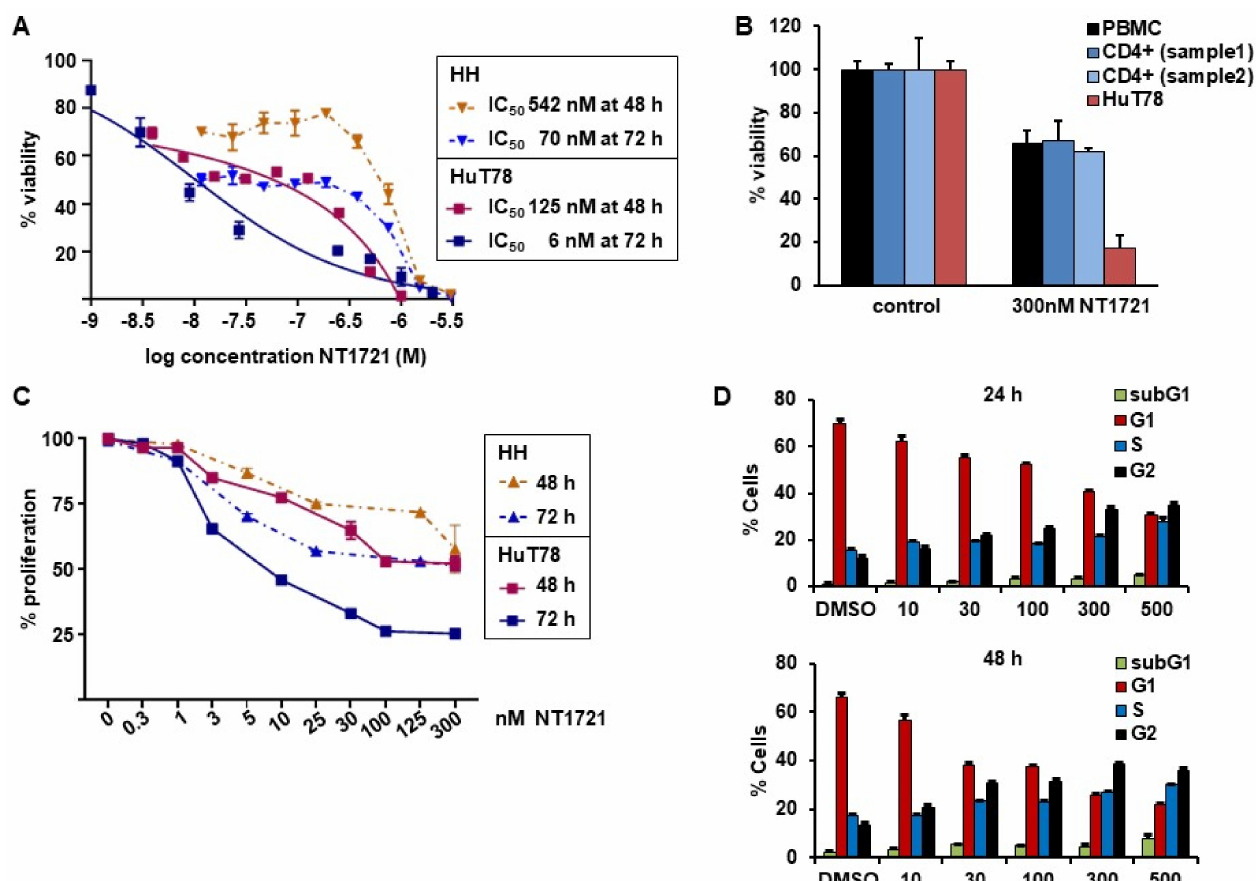
Figure 1. NT1721 decreased CTCL cell viability, proliferation and led to G2 cell cycle arrest. ( A ) Cell viability. HuT78 and HH cells were treated with increasing concentrations of NT1721. Cell viability and IC 50 values were determined after 48 and 72 h. ( B ) Effect of NT1721 on normal cells. HuT78 cells, normal PBMCs and normal CD4 + cells were treated with 300 nM NT1721 or 0.3% DMSO. ( C ) Proliferation. CTCL cells were stained with CFSE, treated with NT1721 and subjected to FACS analysis after 48 or 72 h to determine the mean fluorescence intensity. The data were normalized to the controls. ( D ) Cell cycle analysis. HuT78 cells were treated with NT1721, stained with PI after 24 h and 48 h and analyzed by FACS. The graphs represent the mean ± SD from triplicate